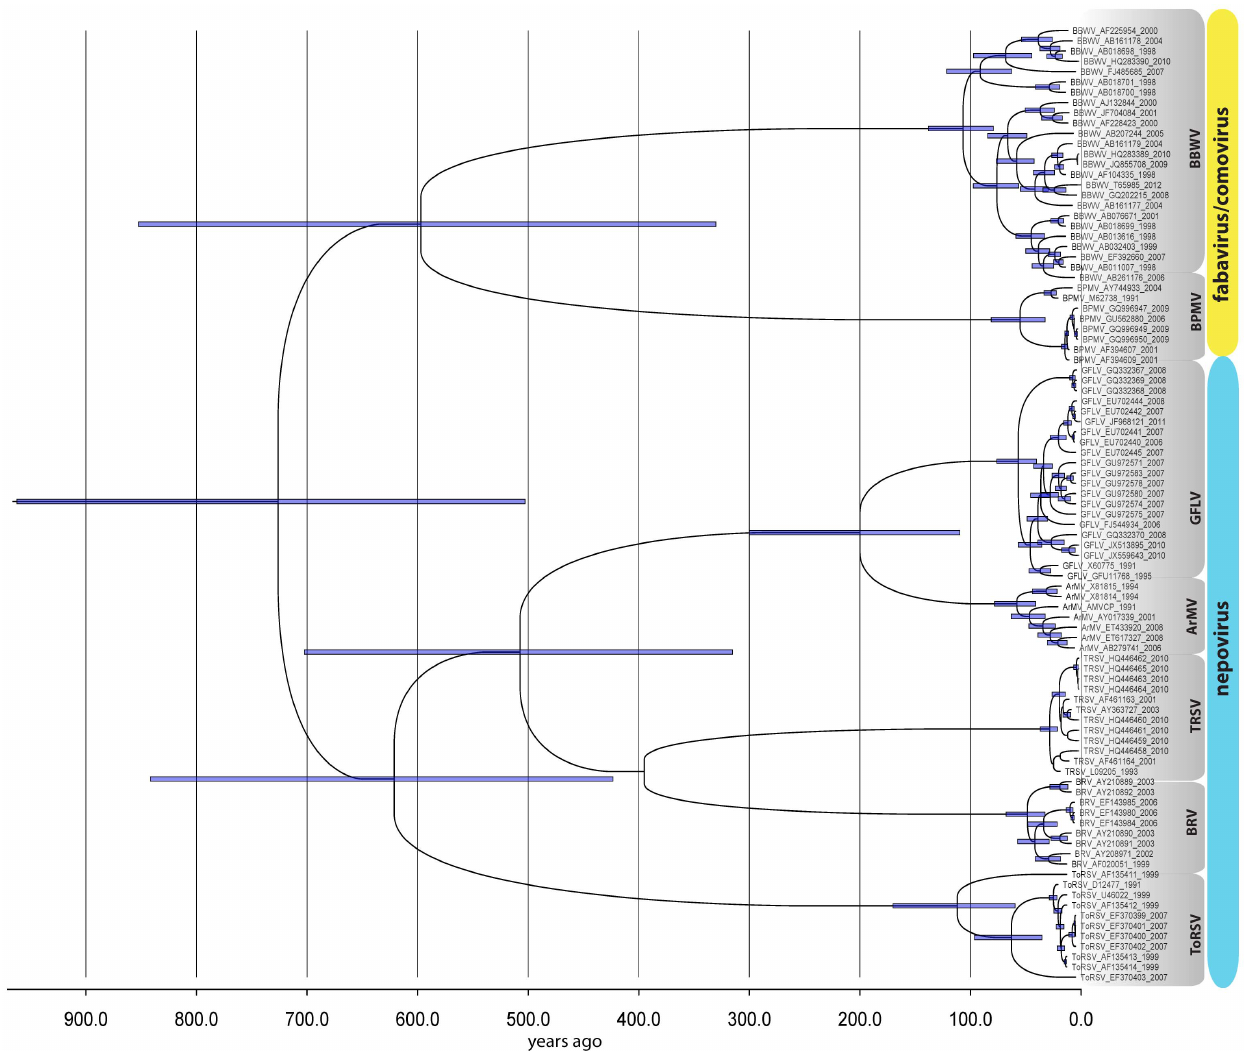
Figure 3. Coalescent tree for the subfamily Comovirinae using coat protein sequences. Bayesian priors were set for a lognormal relaxed molecular clock at the most conservative mean species nucleotide substitution estimate of 2.74 6 10-3 (for ToRSV) using a constant tree prior with all species’ sequences ‘time-stamped’. Horizontal blue bars show the 95% highest posterior density (HPD) ranges for each node. The presence of the HPD bar denotes a node posterior probability greater than 0.9. Arabis mosaic virus (ArMV), Bean pod mottle virus (BPMV), Broad bean wilt virus-2 (BBWV-2), Blackcurrant reversion virus (BRV), Grapevine fanleaf virus (GFLV), Tomato ringspot virus (ToRSV) and Tobacco ringspot virus (TRSV). The equivalent tree generated using a strict clock is shown in the supplemental data.